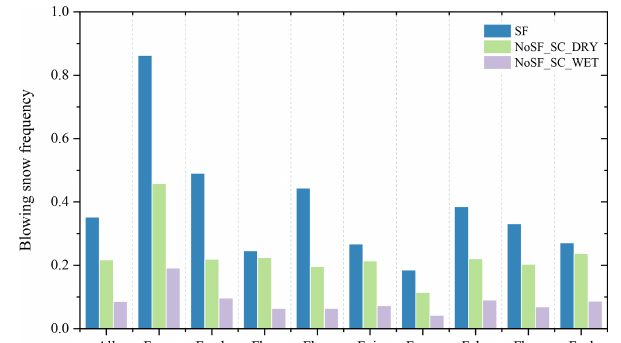
Figure 2. The frequencies of occurrence of the three types of blowing snow at each station and at all stations combined. SF de- notes snowfall condition and NoSF_SC_DRY denotes surface cov- ered by dry snow without concurrent snowfall condition, and NoSF_SC_WET denotes the surface covered by wet snow without a concurrent snowfall condition. The blowing snow frequency de- notes the ratio between occurrences of blowing snow for a given atmospheric condition divided by the total number of occurrences of this atmospheric